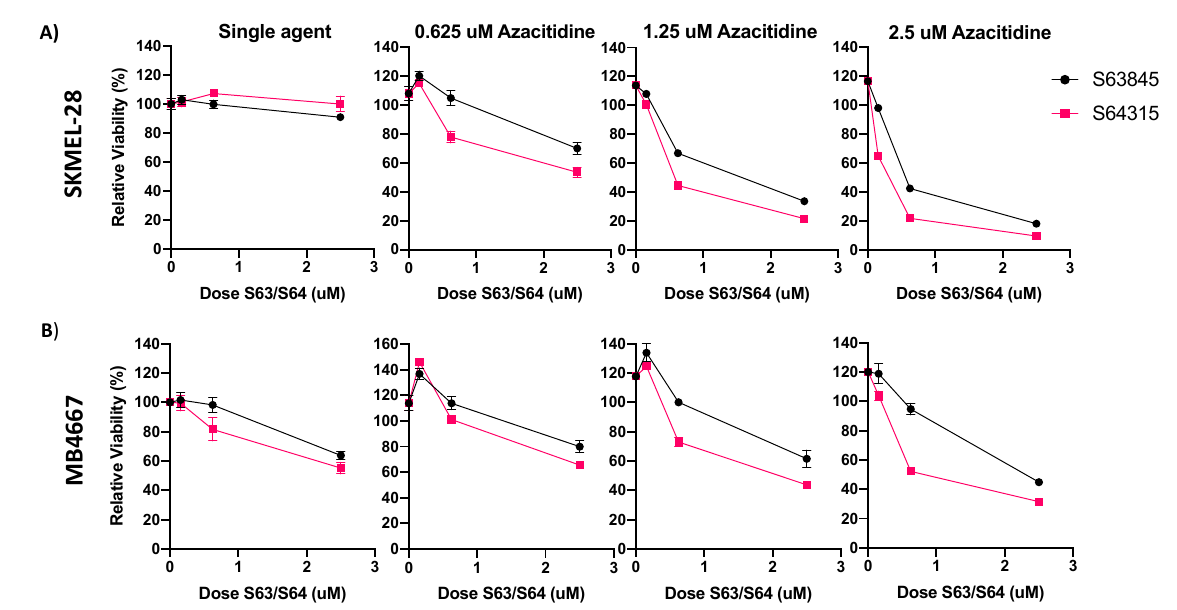
Figure 4. S63845 and clinical grade version S64315 (MIK665) have similar efficacy in melanoma cell lines. ( A ) ATP assay of S63845 or S64315 plus AZA in SKMEL-28. ( B ) ATP assay of S63845 or S64315 plus AZA in MB4667. Dose of AZA indicated in title of graph. Y axis indicates viability relative to DMSO control, set to 100%. X axis indicates S63845/S64315 dosage. Error bars represent +/ − SEM.